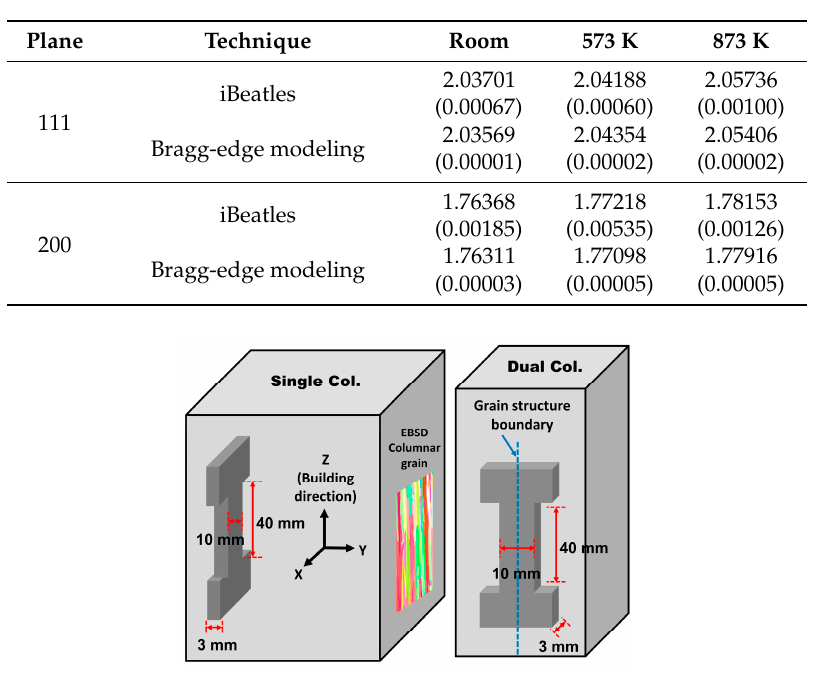
Figure 4. Schematic illustrations of dimension and orientation of single Col. and dual Col., extracted from the additively manufactured (AM) bulk blocks. An electron backscatter diffraction (EBSD) image shows how the columnar grains form in the single Col. sample.